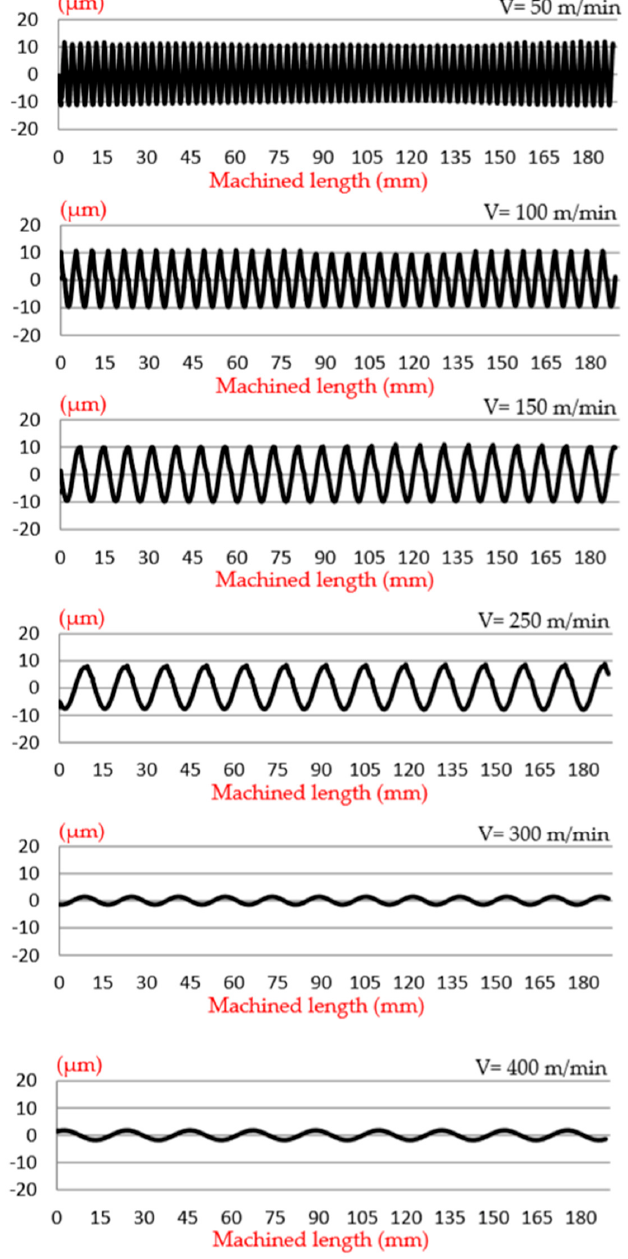
Figure 3. Simulated surface profile: effect of cutting speed (uncut chip thickness = 0.01 mm; tool rake angle = 0°; width of cut = 1.5 mm).